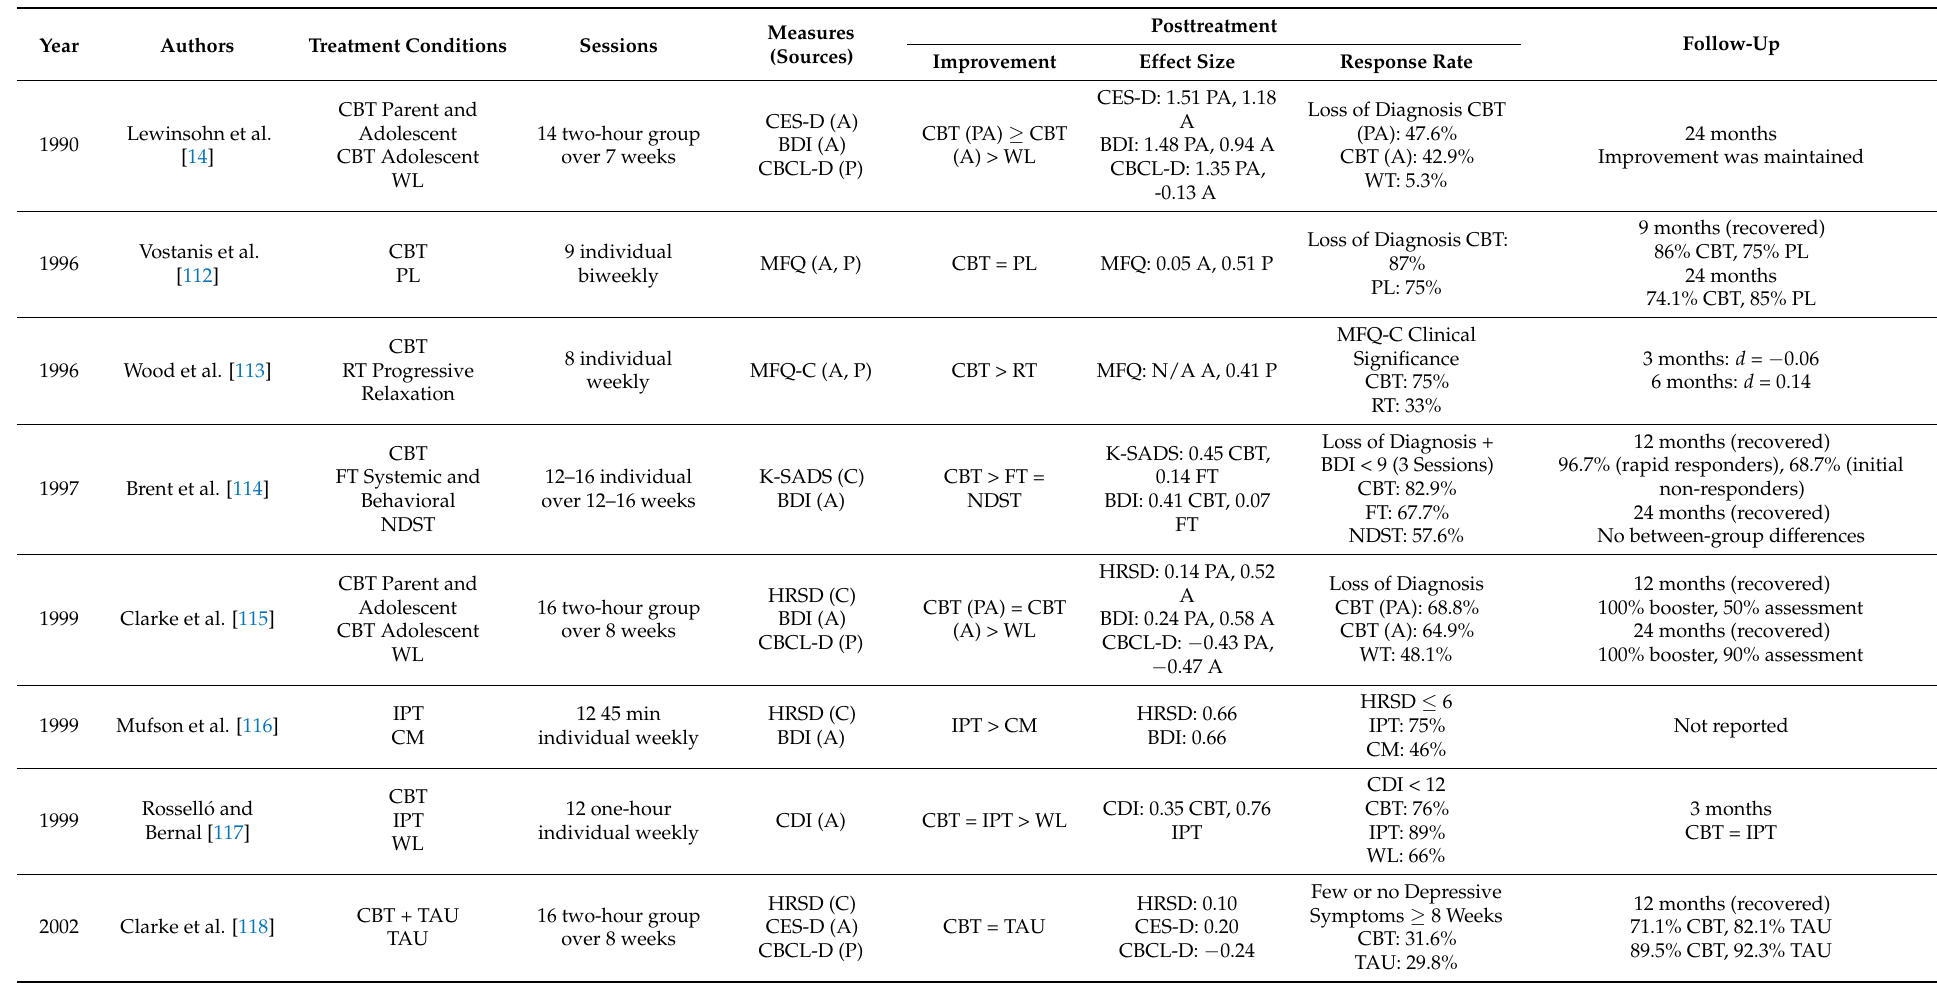
Table 4. Adolescent depression treatment outcome of trials included in the current